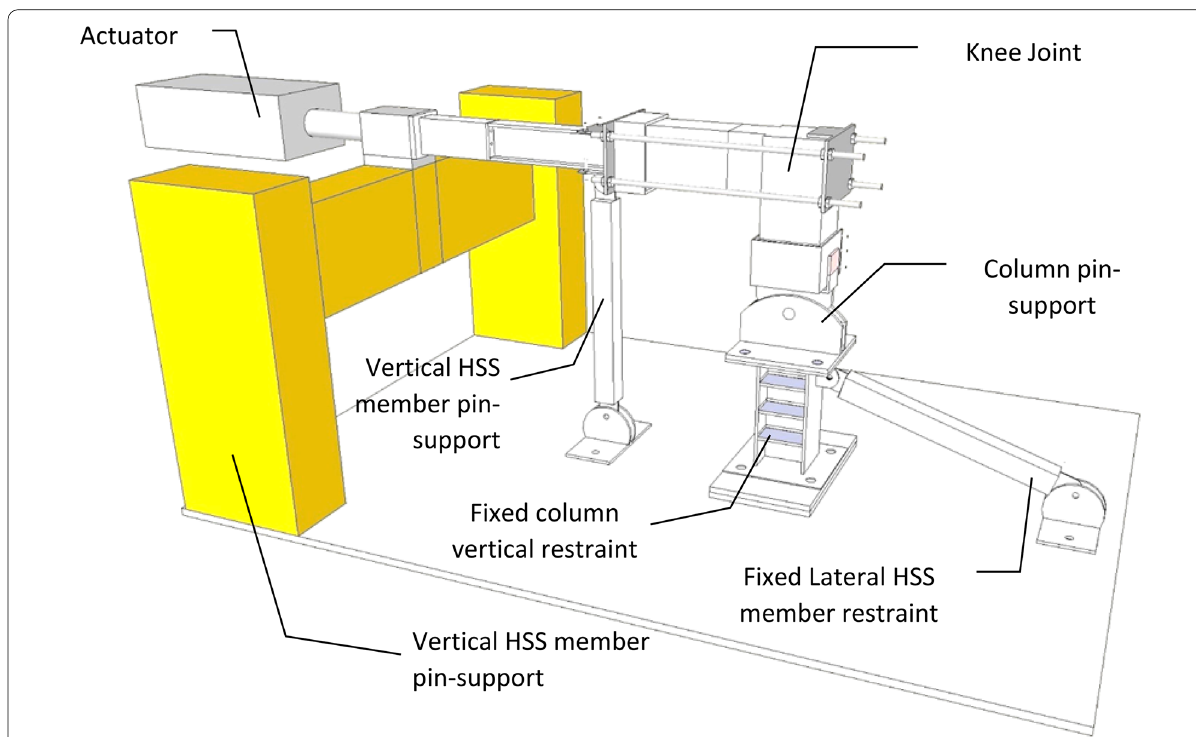
Fig. 7 Experimental test